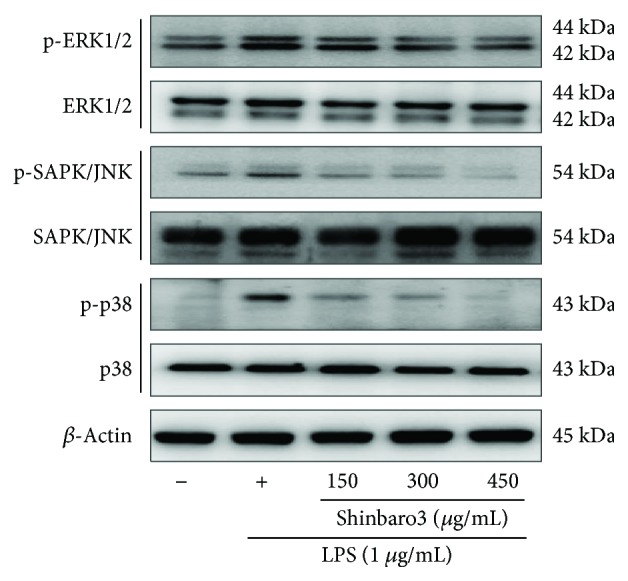
Effects of Shinbaro3 on MAPK phosphorylation in LPS-stimulated RAW 264.7 cells. RAW 264.7 cells were treated with LPS (1 μg/mL) and Shinbaro3 (150, 300, and 450 μg/mL) for 2 h. Total cell lysates were analysed via Western blotting using antiphospho-ERK1/2, antiphospho-SAPK/JNK, and antiphospho-p38 antibodies. β-Actin was used as an internal control. The data are representative of three separate experiments.